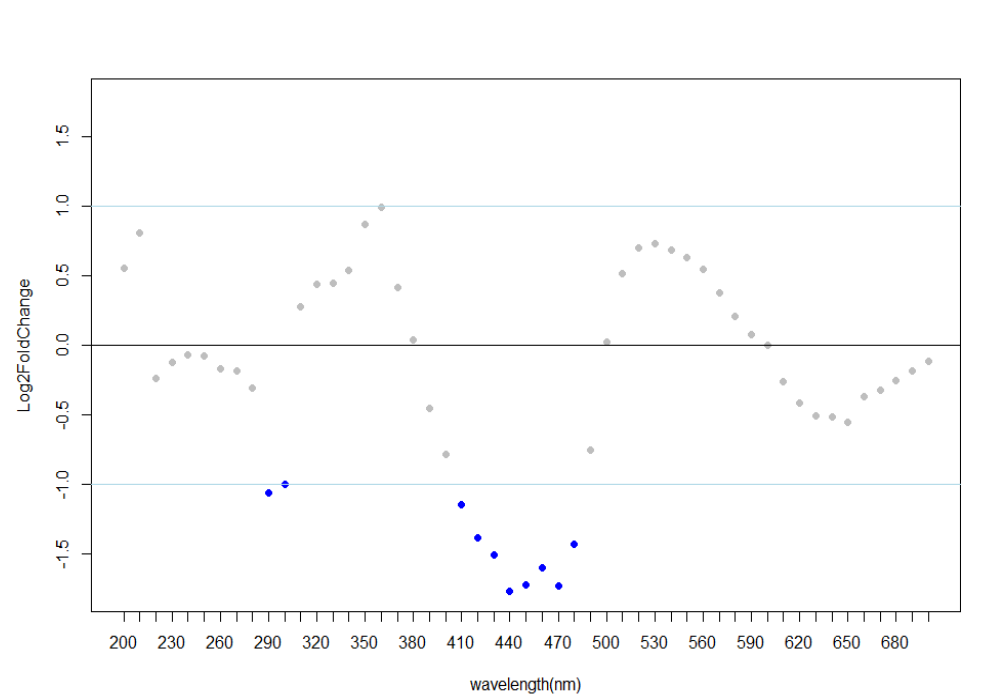
Figure 2: Fold change analysis of the UV-Vis data set ( λ = 200-700 nm, acetone: petroleum ether - v/v). Significant differences (blue symbols) in the relative intensity (defined as a ≥ 2-fold change) of absorbance signals important for discriminating the samples where detected between 400 and 500 nm (carotenoids fingerprint